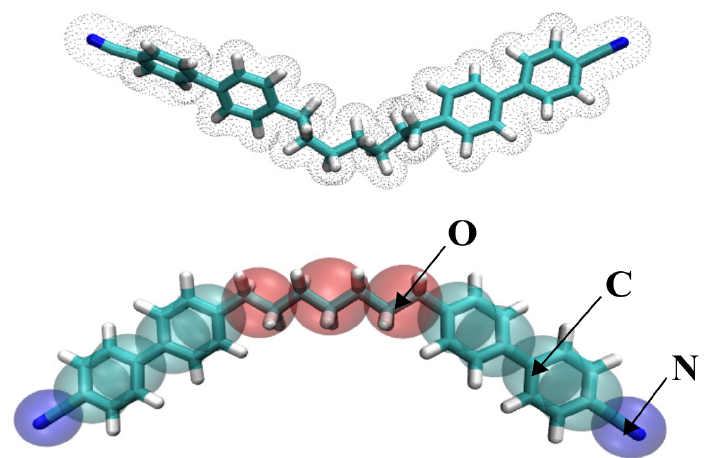
Figure 1. ( Top ): Snapshot conformation of a single CB7CB molecule showing the 3D atomistic struc- ture. ( Bottom ): Coarse-grained mapping scheme showing the three types of coarse-grained beads used in this work (termed N, C, O). Each bead incorporates heavy atoms and attached